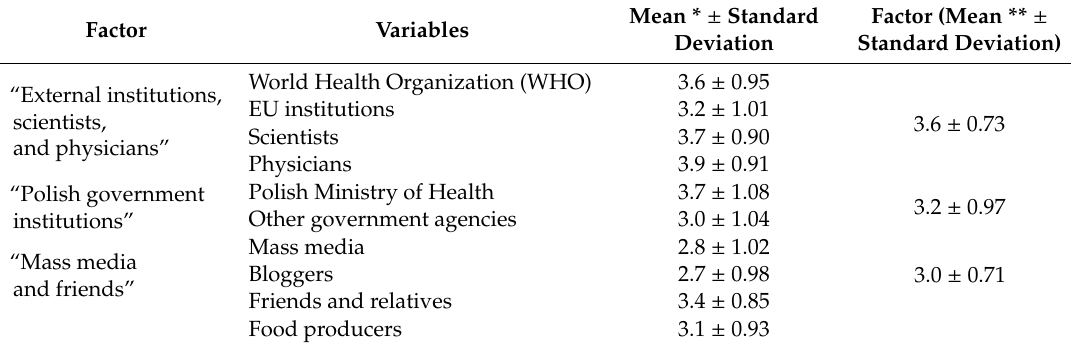
Table 3. Consumers’ trust in selected sources of information on the COVID-19 pandemic.